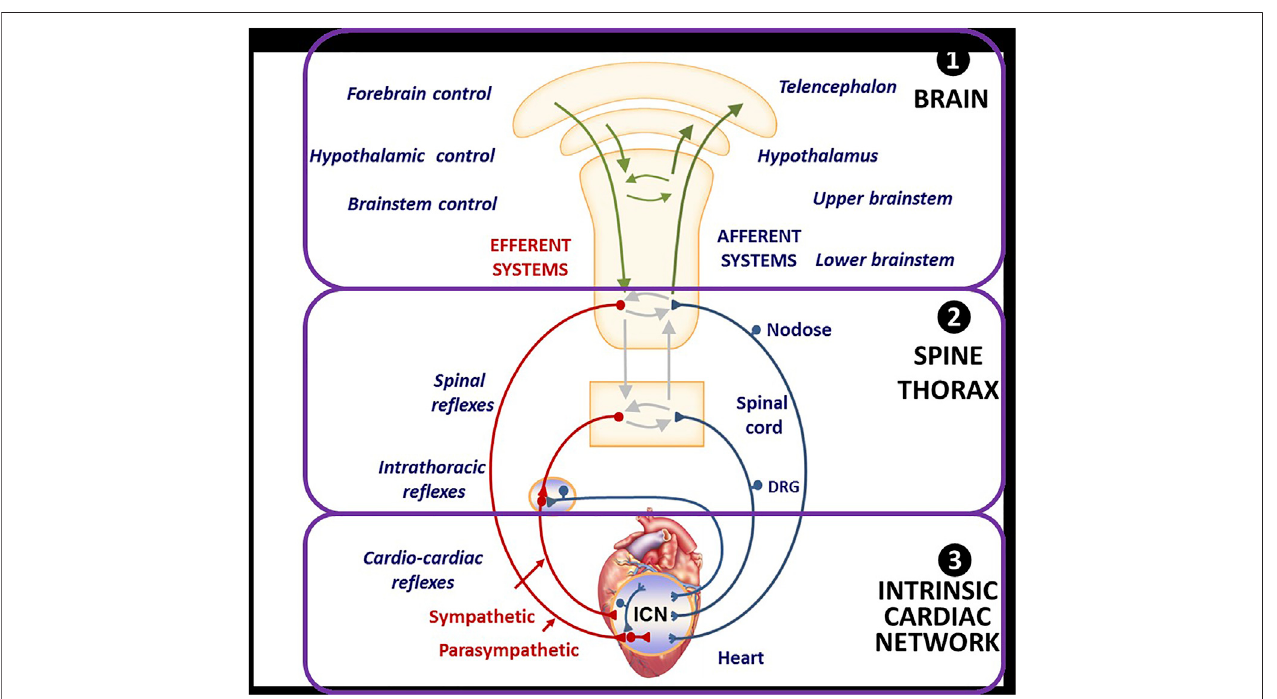
FIGURE1| Organizationand Function ofAutonomic NervousSystemforNeuromodulationand Cardiac Control.DRG =Dorsal rootganglia,agroupofcellbodies responsible for the transmission of sensory messages from receptors such as thermoreceptors, nociceptors, proprioceptors, and chemoreceptors, to the central nervous system. ICN = intracardiac network, a “ little brain ” of the heart comprising intracardiac ganglia and interconnecting neurons making adjustments of the cardiac mechanical and electrical activity comprising intracardiac ganglia and interconnecting neurons. From Hanna H, Shivkumar K, and Ardell J. Card Fail Review 2018; 4: 92 – 98, with permission.